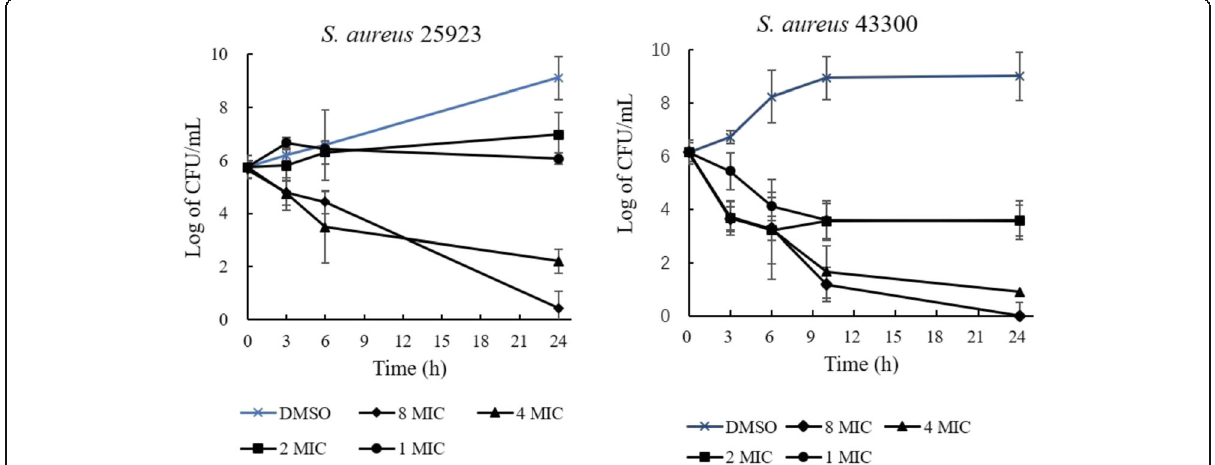
Fig. 3 Time-dependent killing activities of S3 on the strains ATCC 25923 and ATCC 43300. All the CFU values are the average of 6 repeats